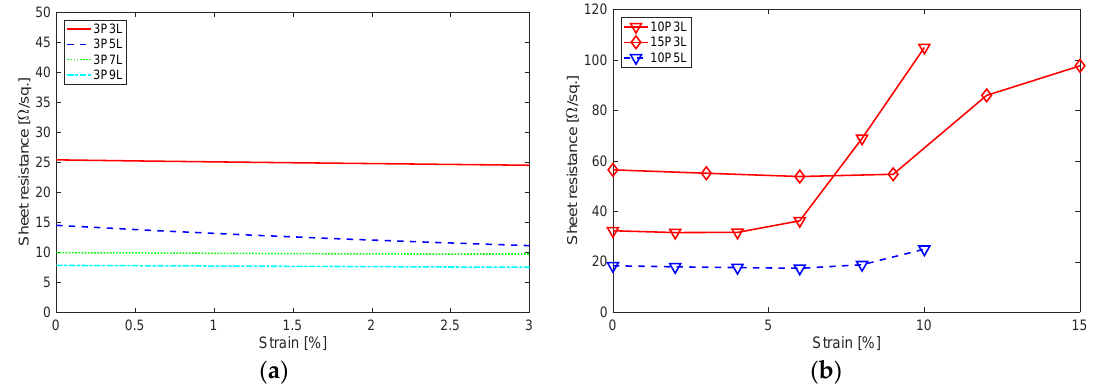
Figure 10. Effect of applied tensile strain on the sheet resistance is shown for ( a ) the 3% pre-strain specimen and ( b ) high pre-strain specimens fabricated at 10% and 15% pre-strain.